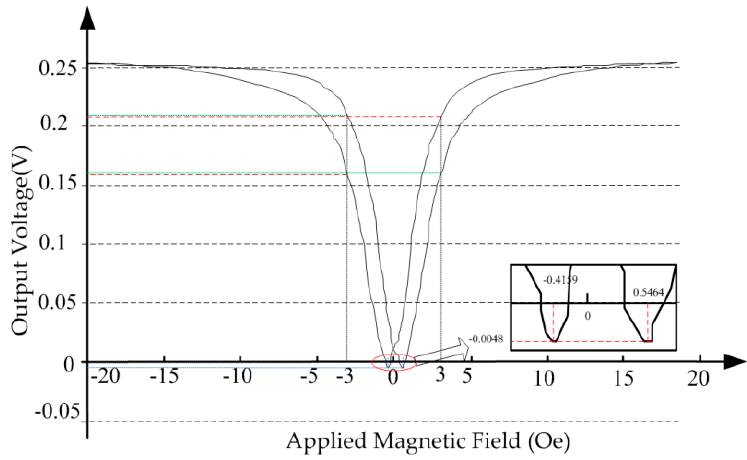
Figure 4. Giant magneto resistance (GMR) sensor output under 25 °C.